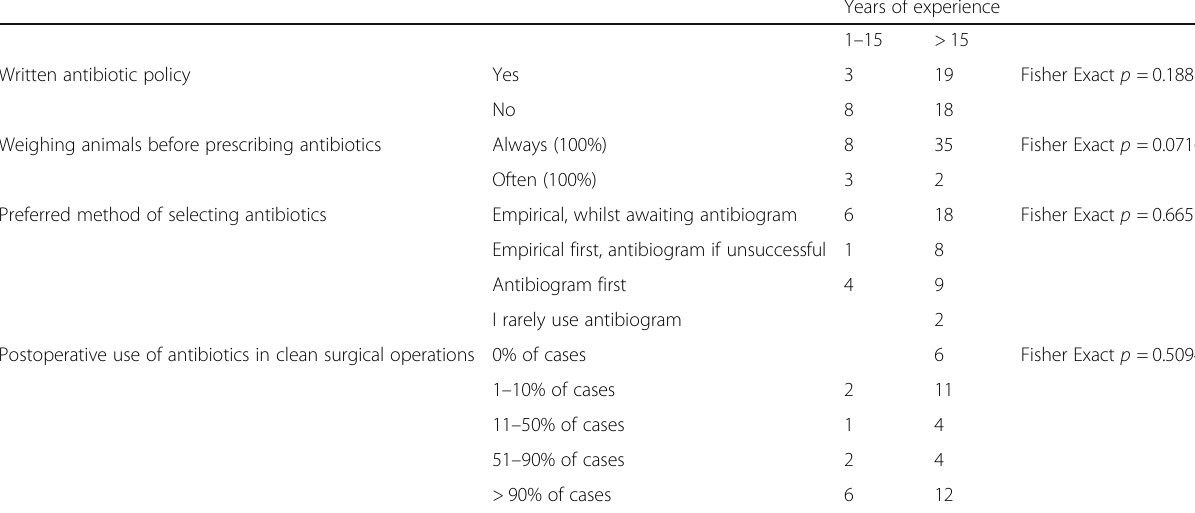
Table 4 Correlation between veterinarians ’ years of experience and aspects of small animal practise